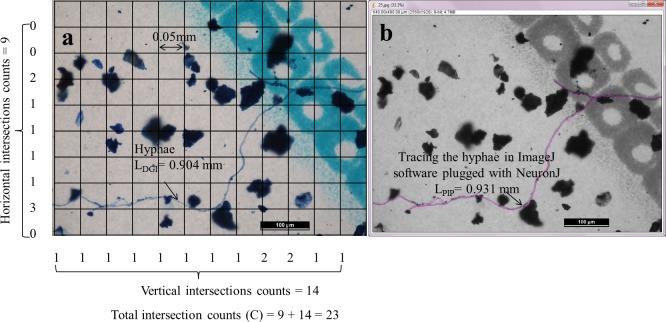
AMF hyphae on an image taken under a microscopy at ×100 magnification measured by using (a) the DGI method—a grid layer (12 × 9, grid size 0.05 × 0.05 mm) was placed on the image, and the horizontal and vertical intersections of hyphae that crossed the edges of each square were counted and recorded (e.g., C = 23, the hyphal length calculated using the Tenant equation was 0.904 mm); and (b) the PIP method—the hyphae in the same image were traced (pink line) and measured by the ImageJ software with NeuronJ plugin (e.g., L = 0.931 mm).